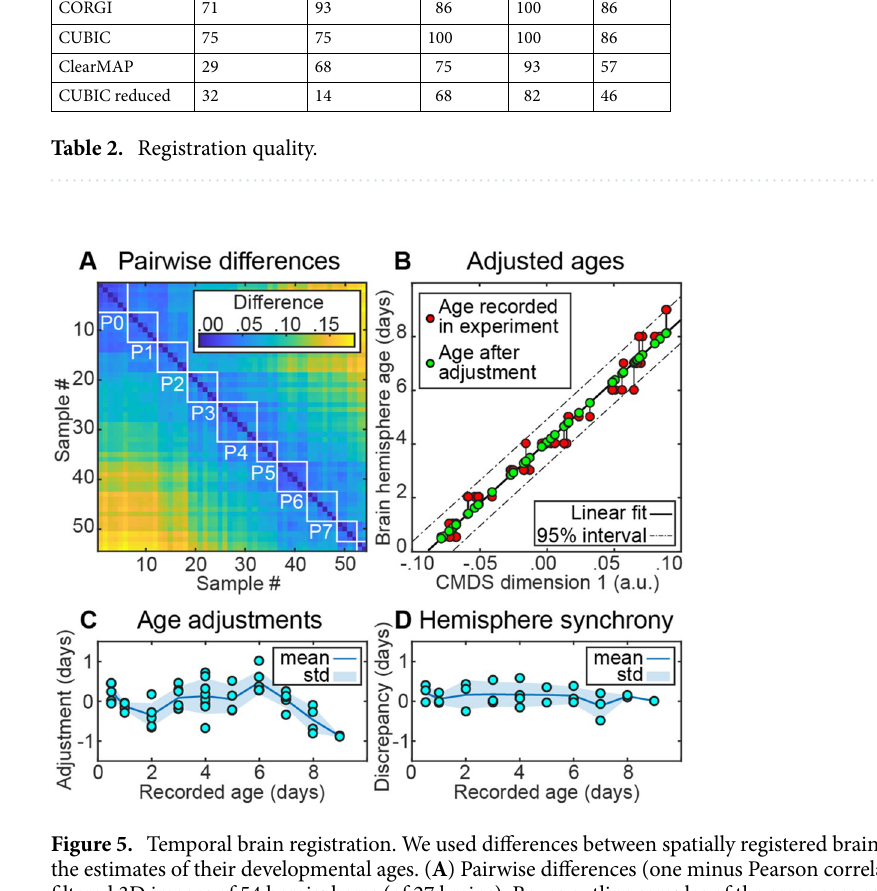
ordered and anonymized. After the expert evaluation, we computed the fractions of satisfactory alignments for each algorithm and brain region of interest shown in Table 2 below.